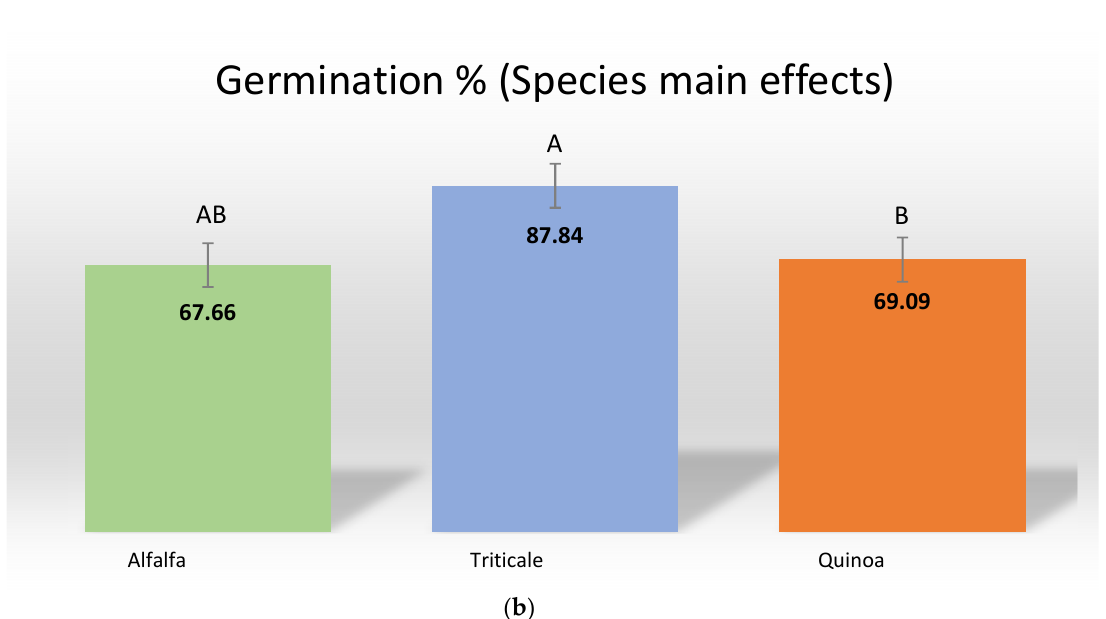
Figure 1. ( a ) Soil main effects on germination %. ( b ) Species main effects on germination %. A, B letters correspond to statistically significant differences at α ≤ 0.05. Results are the mean ±SEs (standard errors). Standard errors for germination% (±4.37) are constant under soil main effects of sand and clay soils. Standard errors for germination% (±5.57) are constant for species main effects of alfalfa, triticale, and quinoa.